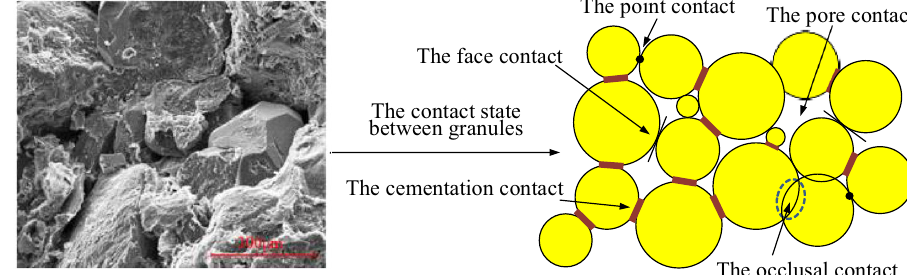
Fig. 1 Microscopic structure of weakly cemented